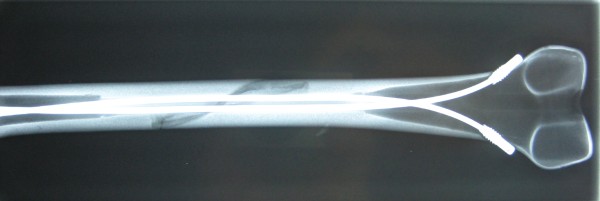
AP Fluoroscopic image of a Sawbone®composite graft with a long spiral fracture after implantation of two elastic stable intramedullary nails with End Caps.